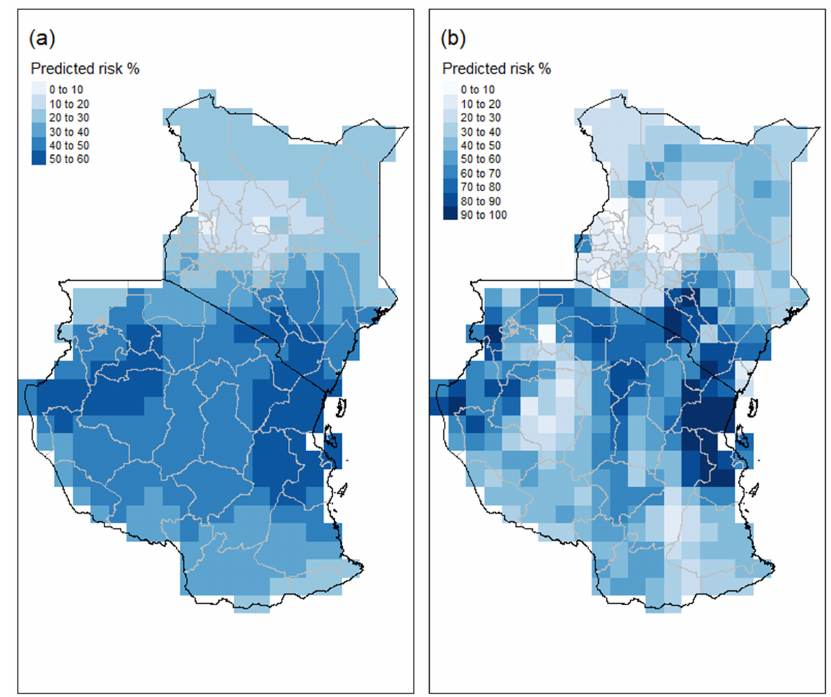
Figure 4. Estimated aflatoxin risk in maize for East Africa for the 2013 season. ( a , b ) Likelihood of harvested maize samples containing aflatoxin based on the logistic regression and random forest models, respectively.